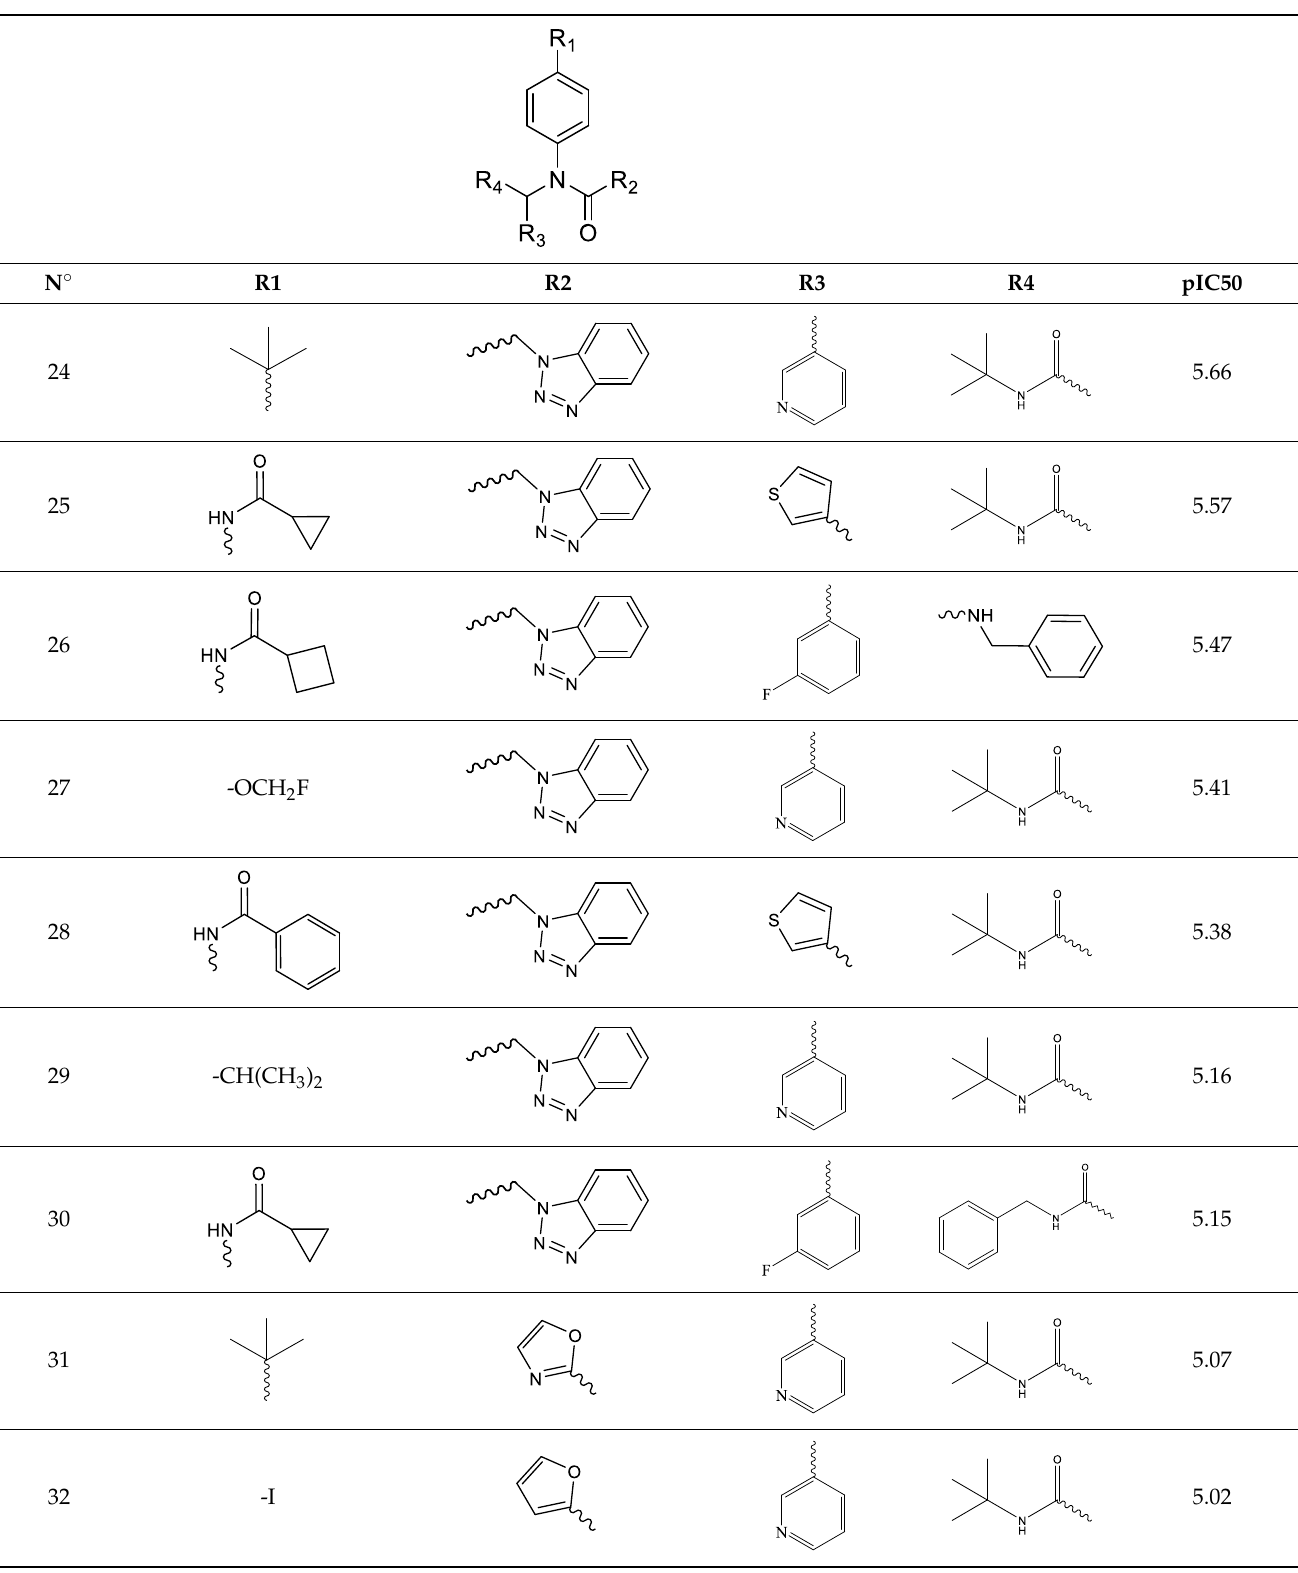
Table 1. Chemical structures and activity experiment of 41 peptidomimetic